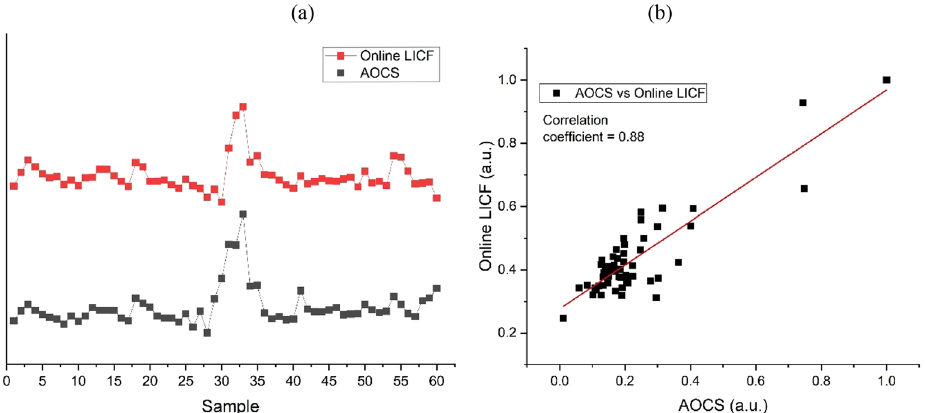
Figure 7. Comparison between the online LICF signal and the AOCS data. The LICF reading were recorded on the spot in the mill. ( a ) The DCO samples were also collected on the spot for AOCS measurement in the laboratory. ( b ) The correlation coefficient for between the two measurement is